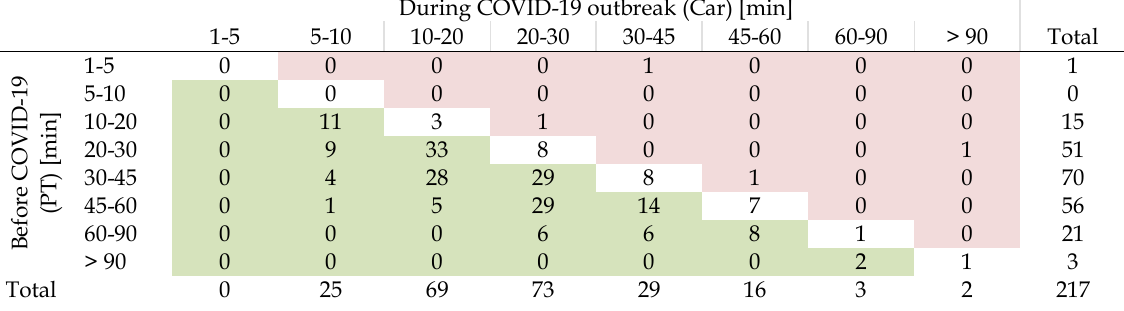
Cross-table of one-way commuting duration before and during COVID-19: public transport to